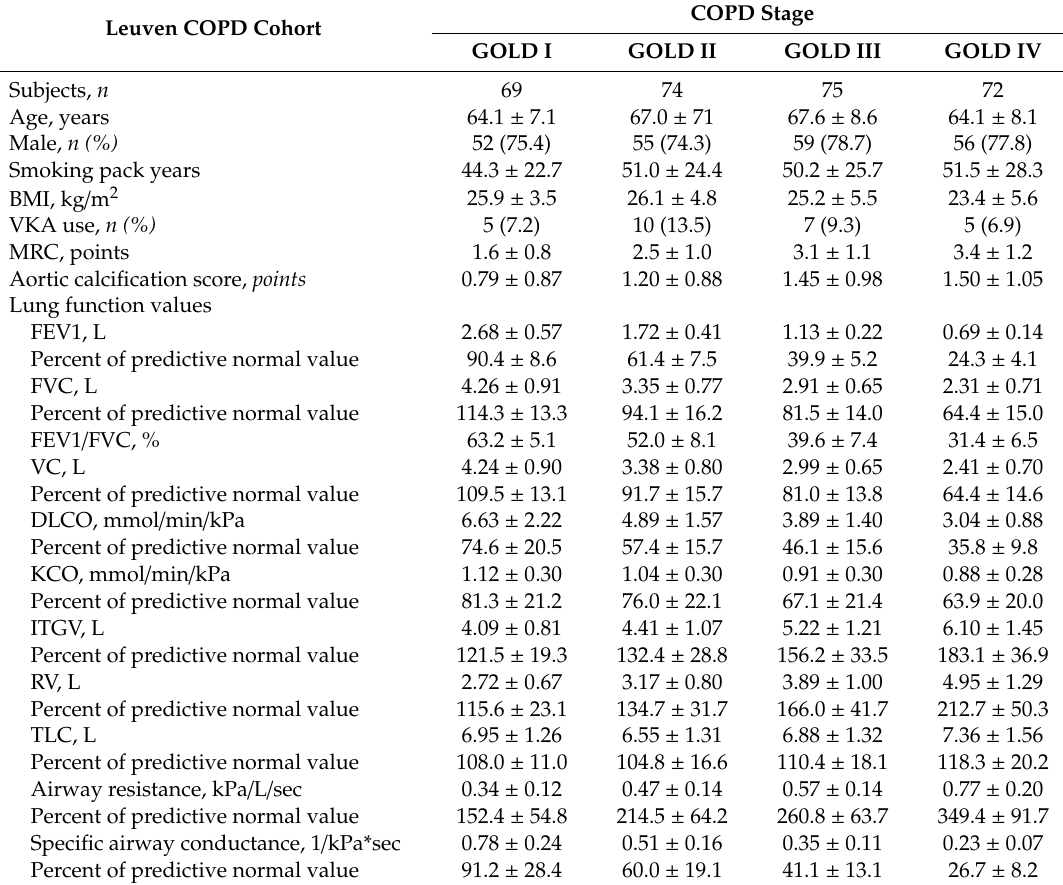
Table 2. Patient characteristics of the Leuven COPD cohort. Continuous data are presented as mean ± standard